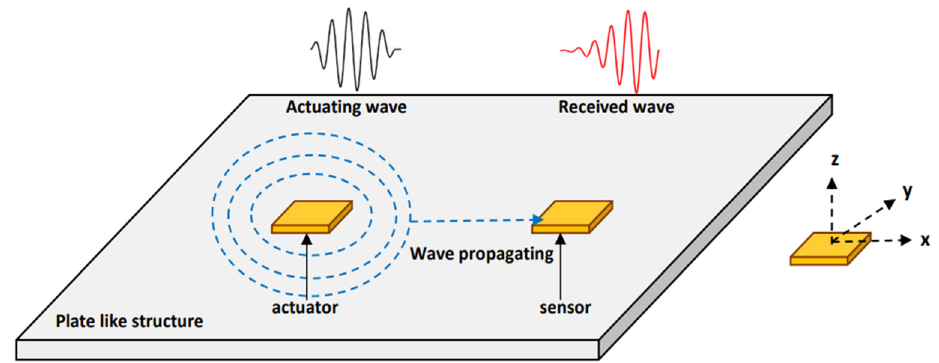
Figure 12. Schematic diagram of wave propagation with PZT transducer.